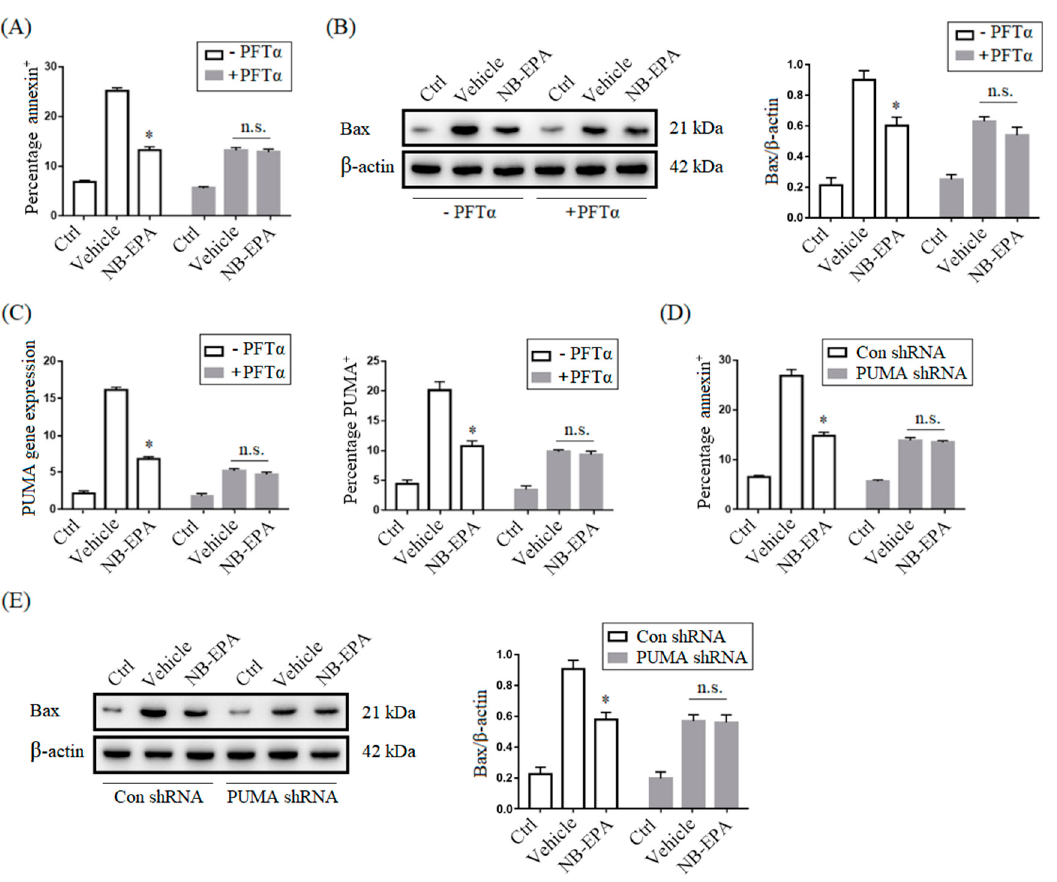
Figure 6. NB-EPA reduces neuron apoptosis through inhibition of the p53–PUMA pathway. ( A ) The percentage of annexin + neurons with or without p53 inhibition at 24 h of culture with or without NB-EPA and after 3 h OGD. ( B ) Representative Western blot images of Bax with or without p53 inhibition at 24 h of culture with or without NB-EPA and after 3 h OGD (left); densitometric analysis of Bax protein expression (right). ( C ) PUMA mRNA expression in neurons at 12 h of culture with or without NB-EPA and after 3 h OGD (left); mean percentages of PUMA protein expression in neurons at 24 h of culture with or without NB-EPA and after 3 h OGD (right). ( D ) The percentage of annexin + neurons with or without PUMA knockdown at 24 h of culture with or without NB-EPA and after 3 h OGD. ( E ) Representative Western blot images of Bax with or without PUMA knockdown at 24 h of culture with or without NB-EPA and after 3 h OGD (left); densitometric analysis of Bax protein expression (right). Data are mean ± SEM ( n = 3 per group). * p < 0.05 compared to vehicle. n.s. not